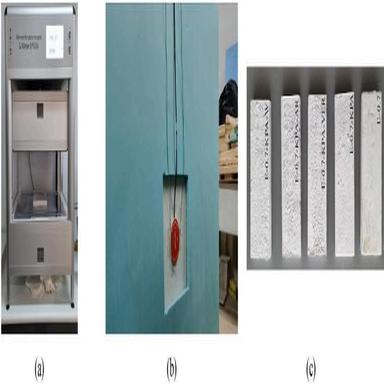
(a) 15 × 15 × 2 cm3 sample set for λ-meter test; (b) 25 × 25 × 2 cm3 sample placed in thermal box; (c) 25 × 9 × 2 cm3 fire test samples.